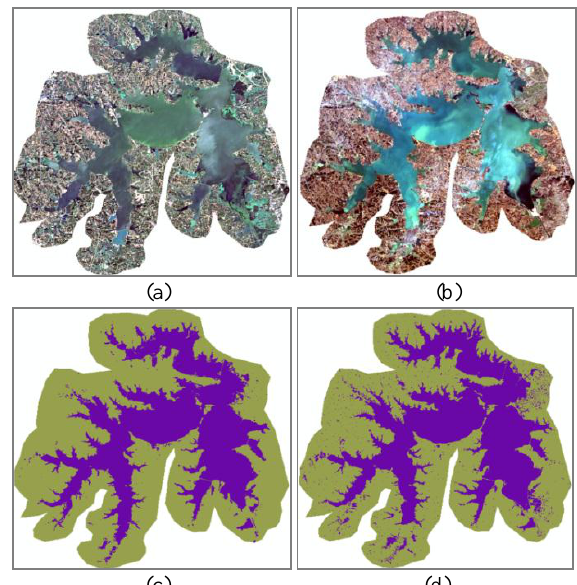
Figure 2. Water extraction results of TM images based on MNDWI